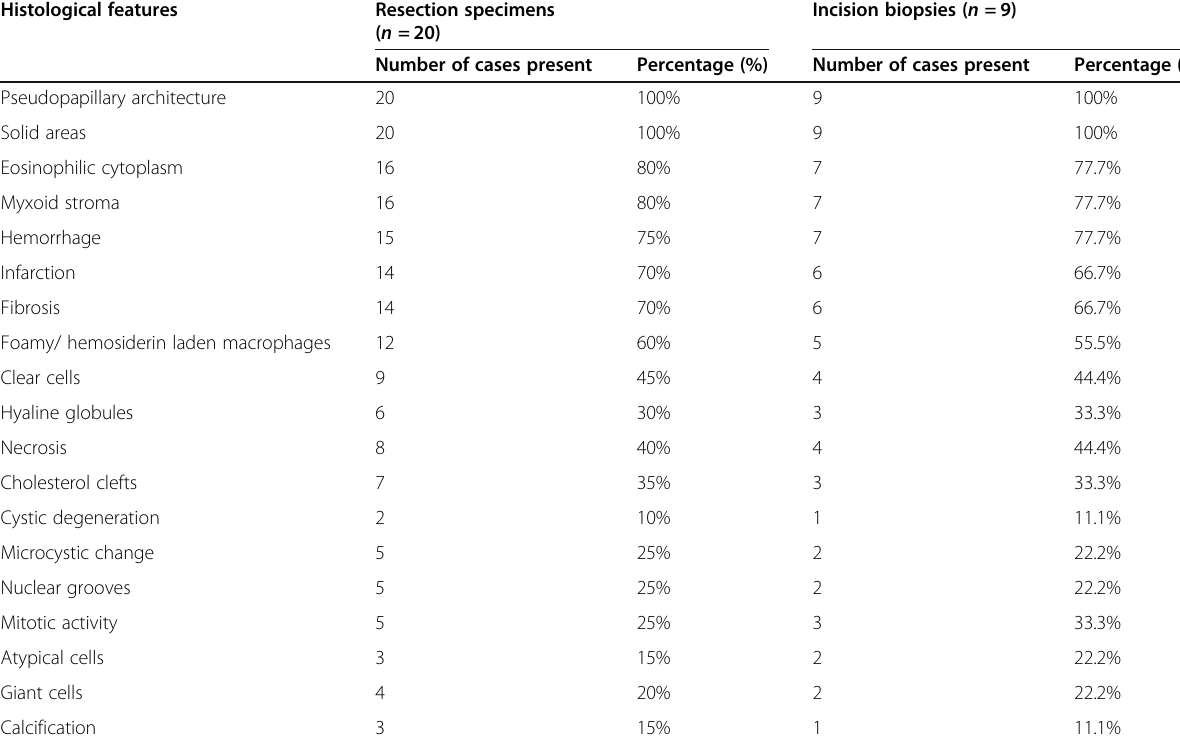
Table 2 Histological features of SPN in patients under 20 years of age ( n = 29)